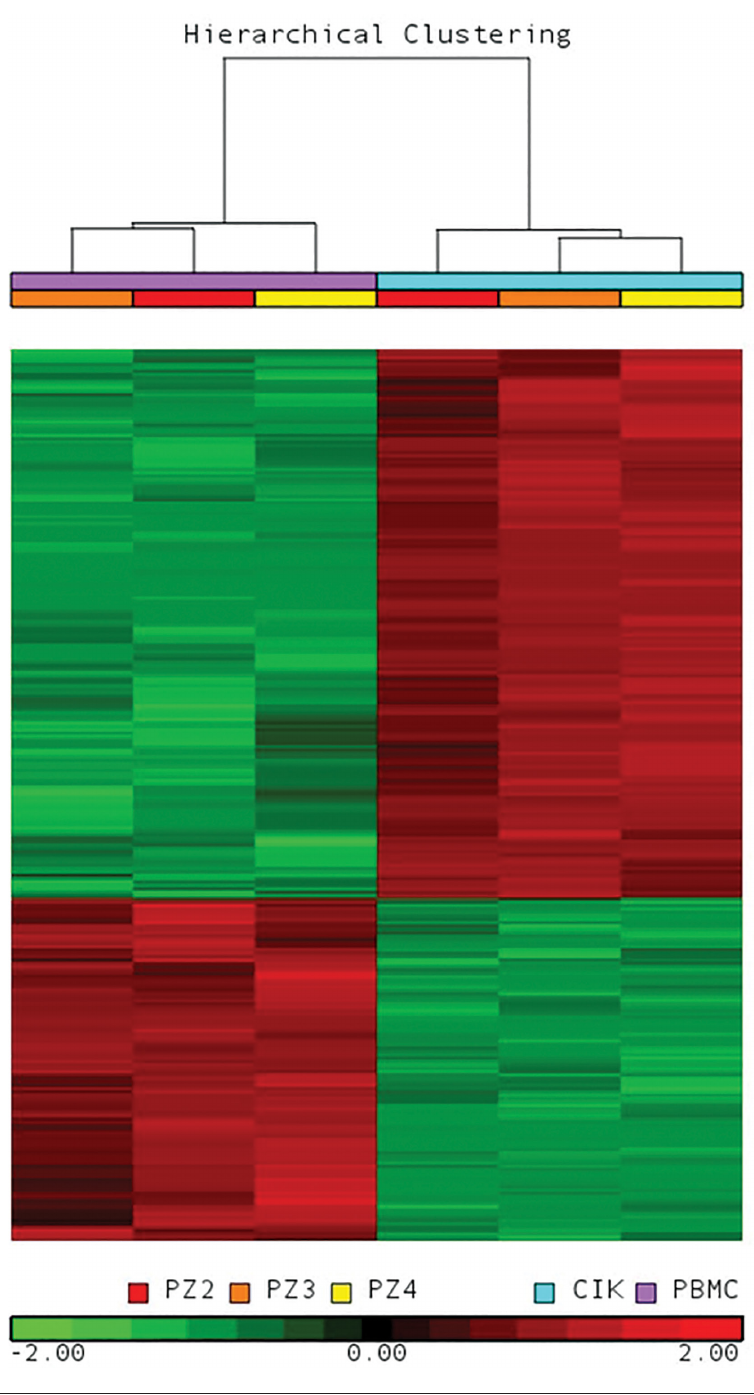
Figure 4. Gene expression profile was analyzed in PBMCs (d 1) and CIK cells (d 14) obtained from three GIST patients. The heat map was computed on the gene list in- cluding 3799 DEGs using the clustering algorithm included in the Partek GS package by means of Euclidean distance and average linkage. Gene coloring is based on normal- ized signals, as shown at the bottom of the figure; green indicates reduced expression, red increased expression. CIK cell and PBMC groups clustered separately in the dendro- gram as shown at the top of the heat